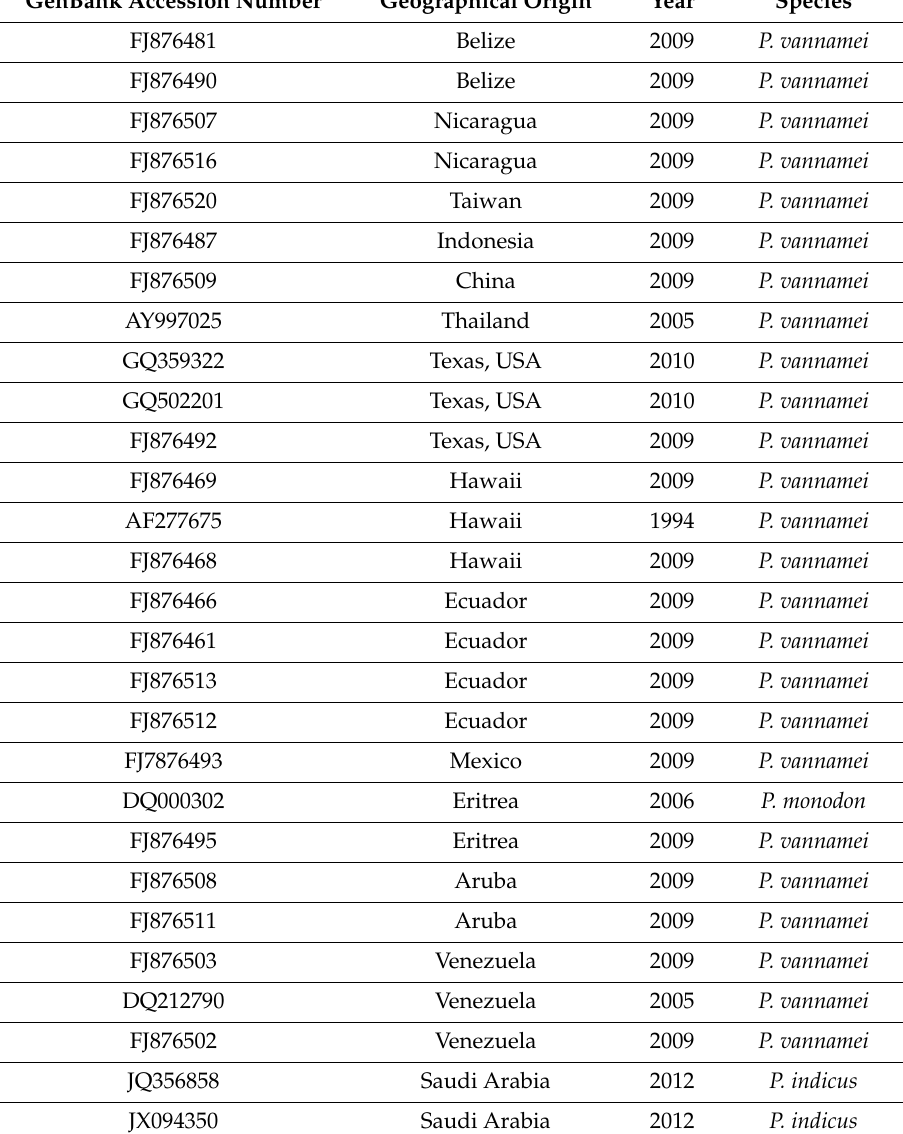
Table 3. GenBank accessions utilized for a phylogenetic analysis of the TSV VP1